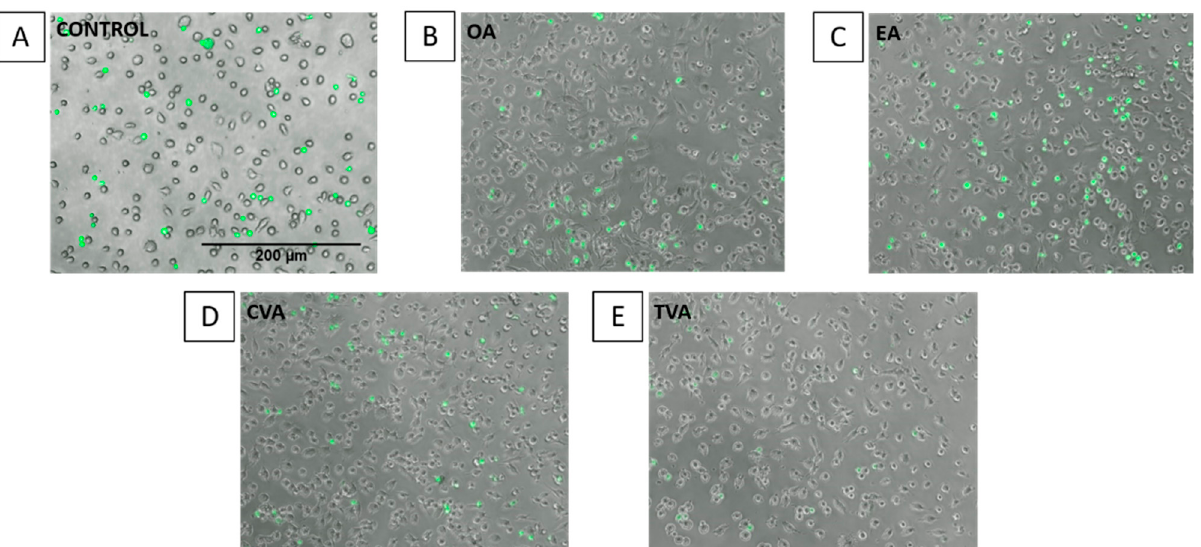
Figure 6. Adhesion of THP-1 cells (% of control) to EA.hy926 cells incubated for 48 h with DMEM containing 0.1% of ethanol (Control) or different concentrations (1 µ M ( A ), 10 µ M ( B ), 50 µ M ( C )) of FA, followed by incubation with TNF- α (1 ng/mL) for 24 h and then 1 h co-incubation with THP-1 cells. Bars are mean ± SEM of 9 samples performed in 3 experiments.